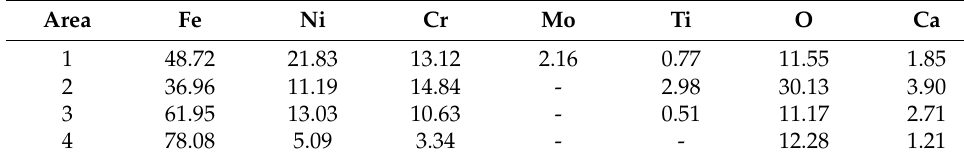
Table 4. The EDS analysis results of different area from the worn surface (wt.%).